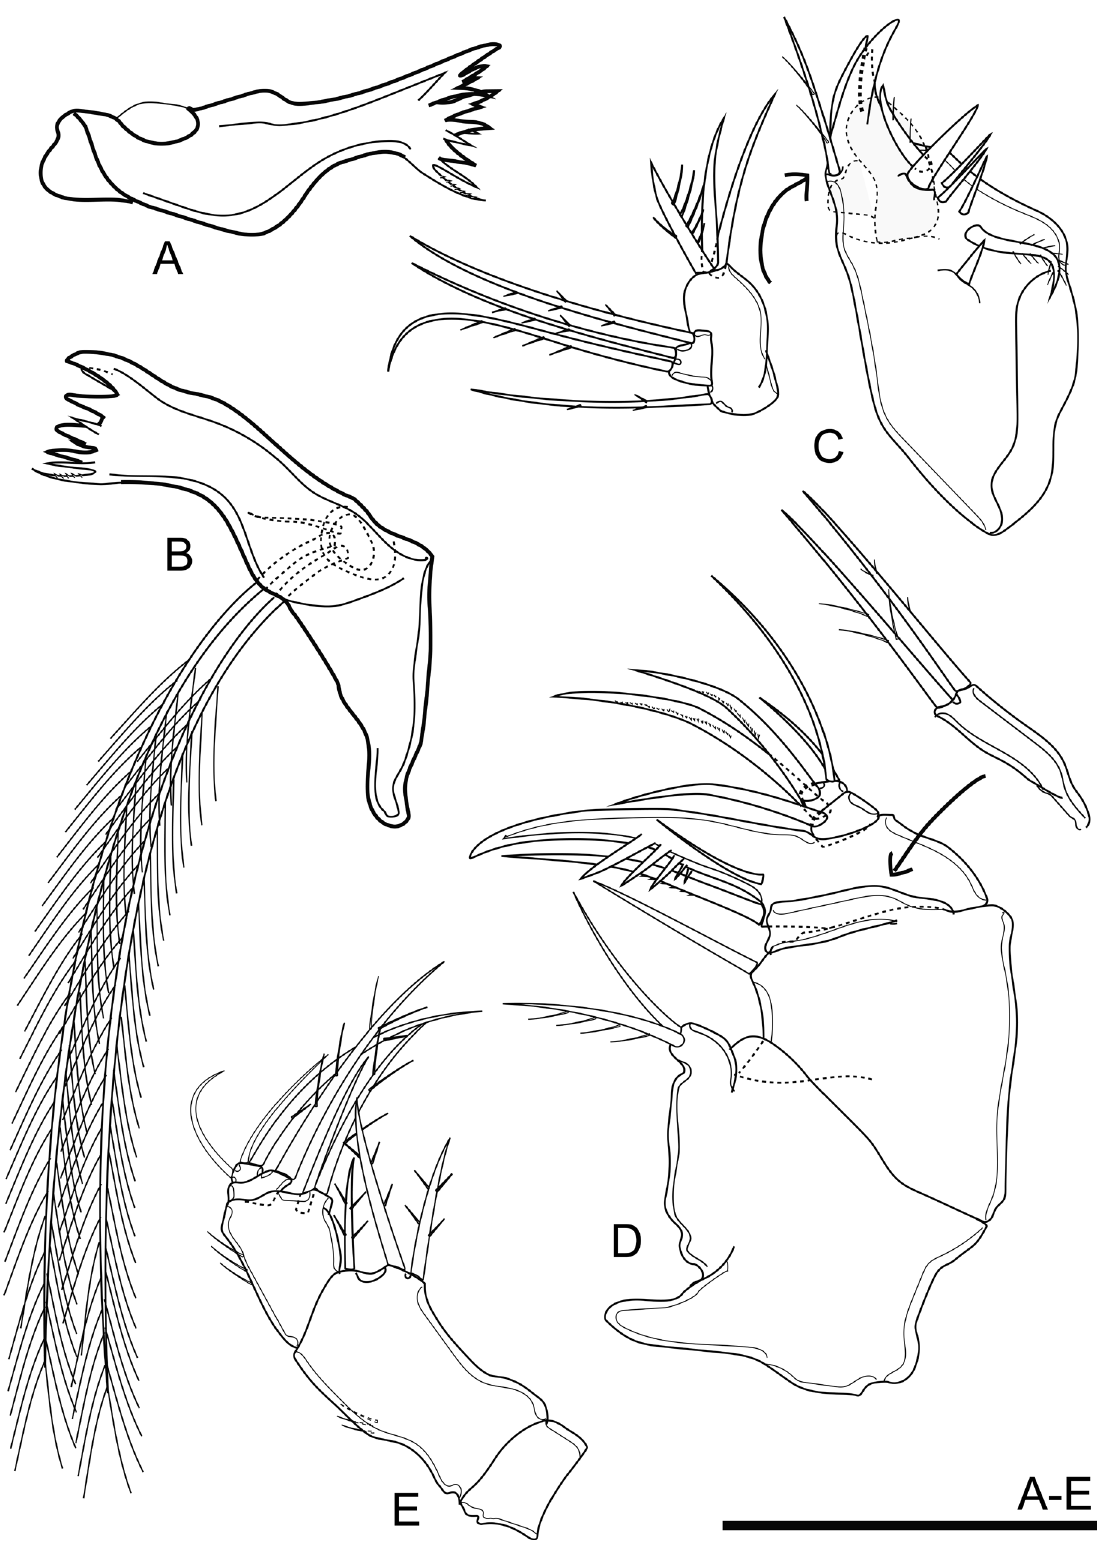
Fig. 6. Metacyclops sakaeratensis sp. nov., holotype, ♀ (ZMB 34230 slide No. 5120). A−B . Right and left mandibles, respectively (the mandibular palp of the right mandible was lost during dissection). C . Maxillule, caudal view. D . Maxilla, caudal view. E . Maxilliped, frontal view. Scale bar = 50